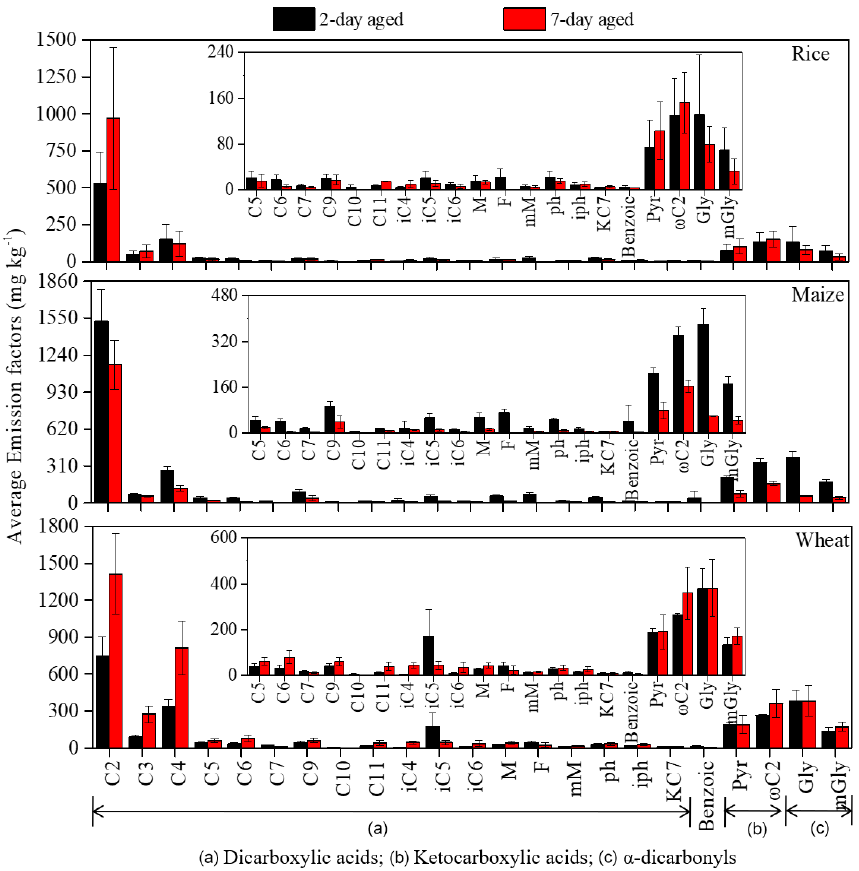
Figure 2. Comparison between 2 and 7d aged average PM 2 . 5 emission factors of the sections marked as follows: (a) dicarboxylic acids, (b) ketocarboxylic acids and (c) α -carbonyls for laboratory combustion of rice, maize and wheat